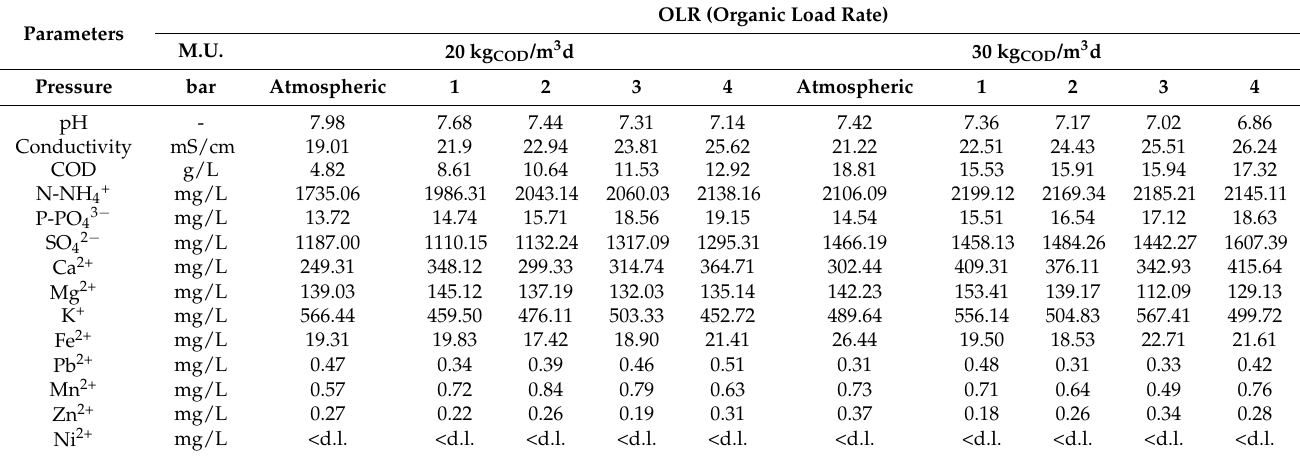
Table 2. Digestate’s chemical–physical characteristics (measure unit (M.U.); detection limit (d.l.)).